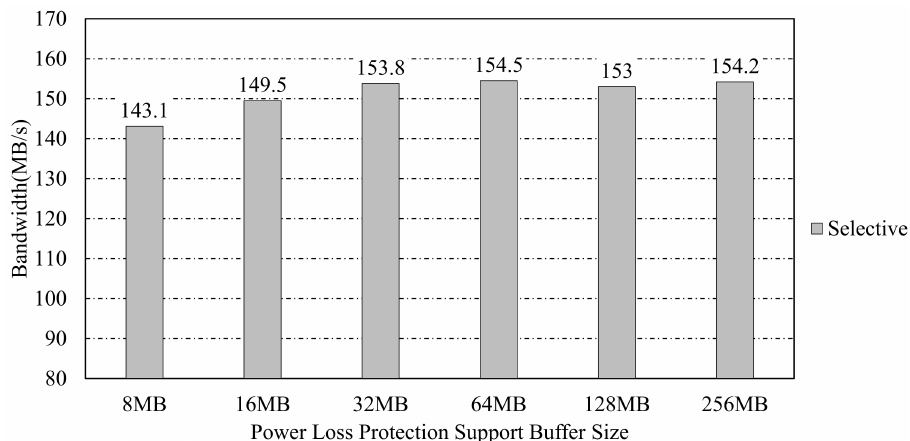
Figure 12. Performance evaluation results of fillseq workload with varying PLP buffer size.